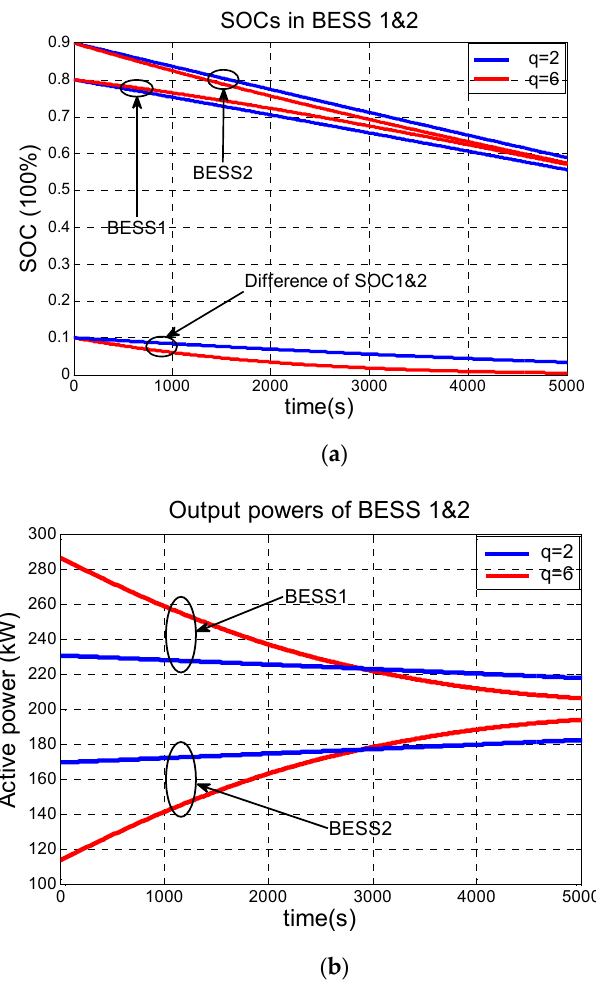
Figure 8. SOC and power sharing waveforms for the adaptive control with different q. ( a ) Waveforms of SOCs and ( b ) waveforms of output powers of BESSs.